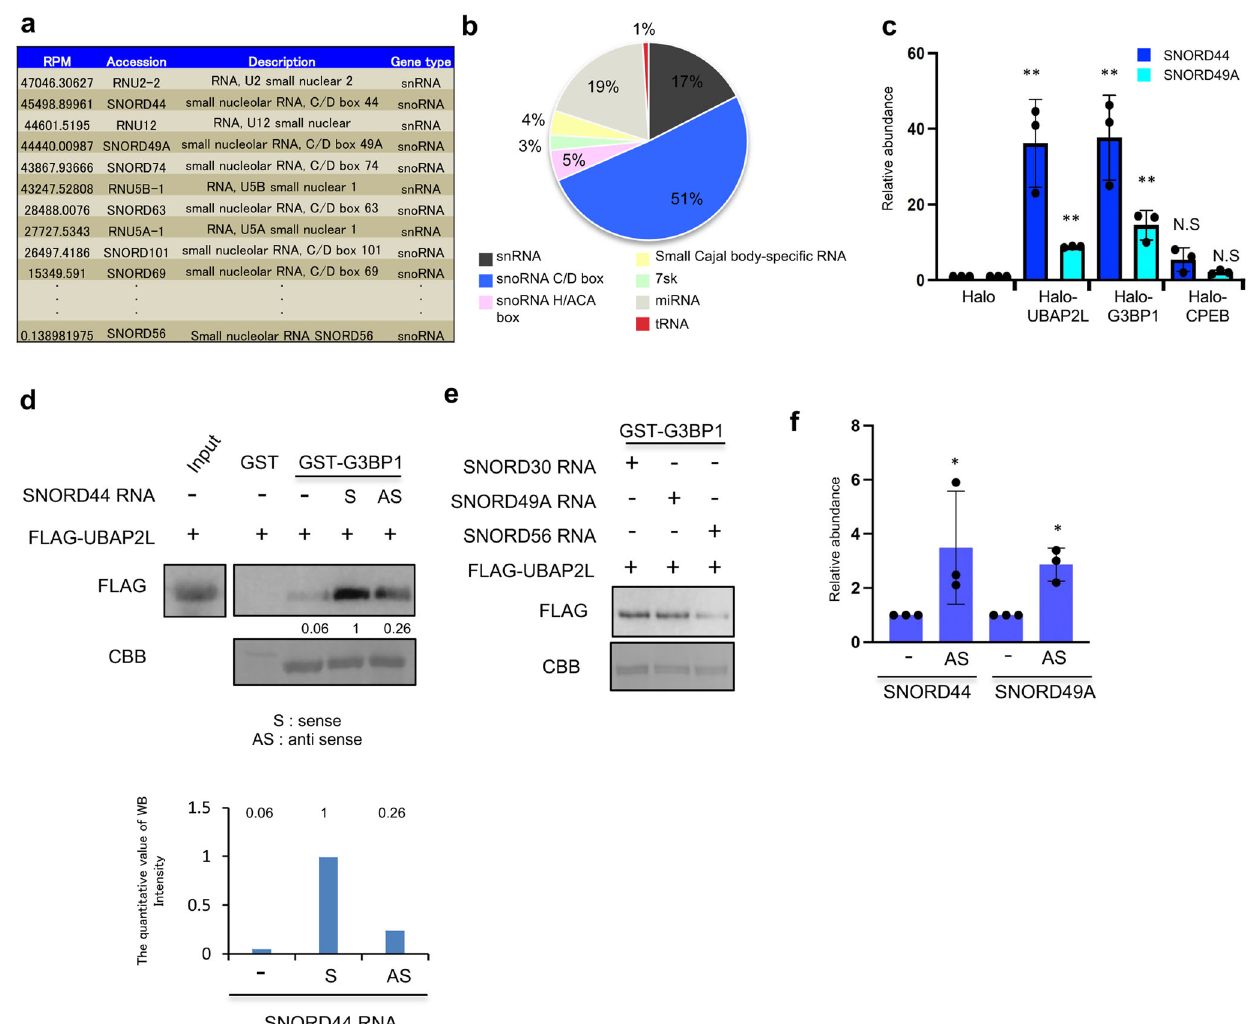
Fig. 5 C/D box snoRNAs mediate the association between UBAP2L and G3BP1. a The small RNAs with the top 10 UBAP2L RPM scores are presented ( n = 2). b The percentages of each type of small RNAs with the top 100 UBAP2L RPM scores are shown in the circle graph ( n = 2). c Small RNAs were isolated from immunoprecipitates from the lysate of 293T cells that constitutively expressed the Halo tag, Halo-UBAP2L, Halo-G3BP1, or Halo-CPEB. The levels of SNORD44 and SNORD49A were examined by quantitative RT-PCR (qRT-PCR) ( n = 3, ** P < 0.01, N.S. (not signi fi cant) P > 0.05). d Immunoprecipitated FLAG-UBAP2L was mixed with recombinant GST or GST-G3BP1 and incubated with or without in vitro-transcribed SNORD44 sense (S) or anti-sense (AS) sequences. Protein-RNA complex precipitated by glutathione agarose beads were immunoblotted with an anti-FLAG antibody. CBB indicates Coomassie brilliant blue staining of recombinant proteins. The number in the middle of the fi gure and the graphs indicates the quantitative value measured with ImageJ. e In vitro-transcribed SNORD30, SNORD49A, or SNORD56 were mixed with immunoprecipitated FLAG-UBAP2L and GST-G3BP1 and subjected to precipitation with glutathione agarose beads followed by immunoblot analysis. Both UBAP2L and G3BP1 RPM scores of SNORD56 is signi fi cantly lower than that of SNORD30 and SNORD49A. f SG core fraction was puri fi ed from arsenate treated HeLa cells and no-treated HeLa cells.